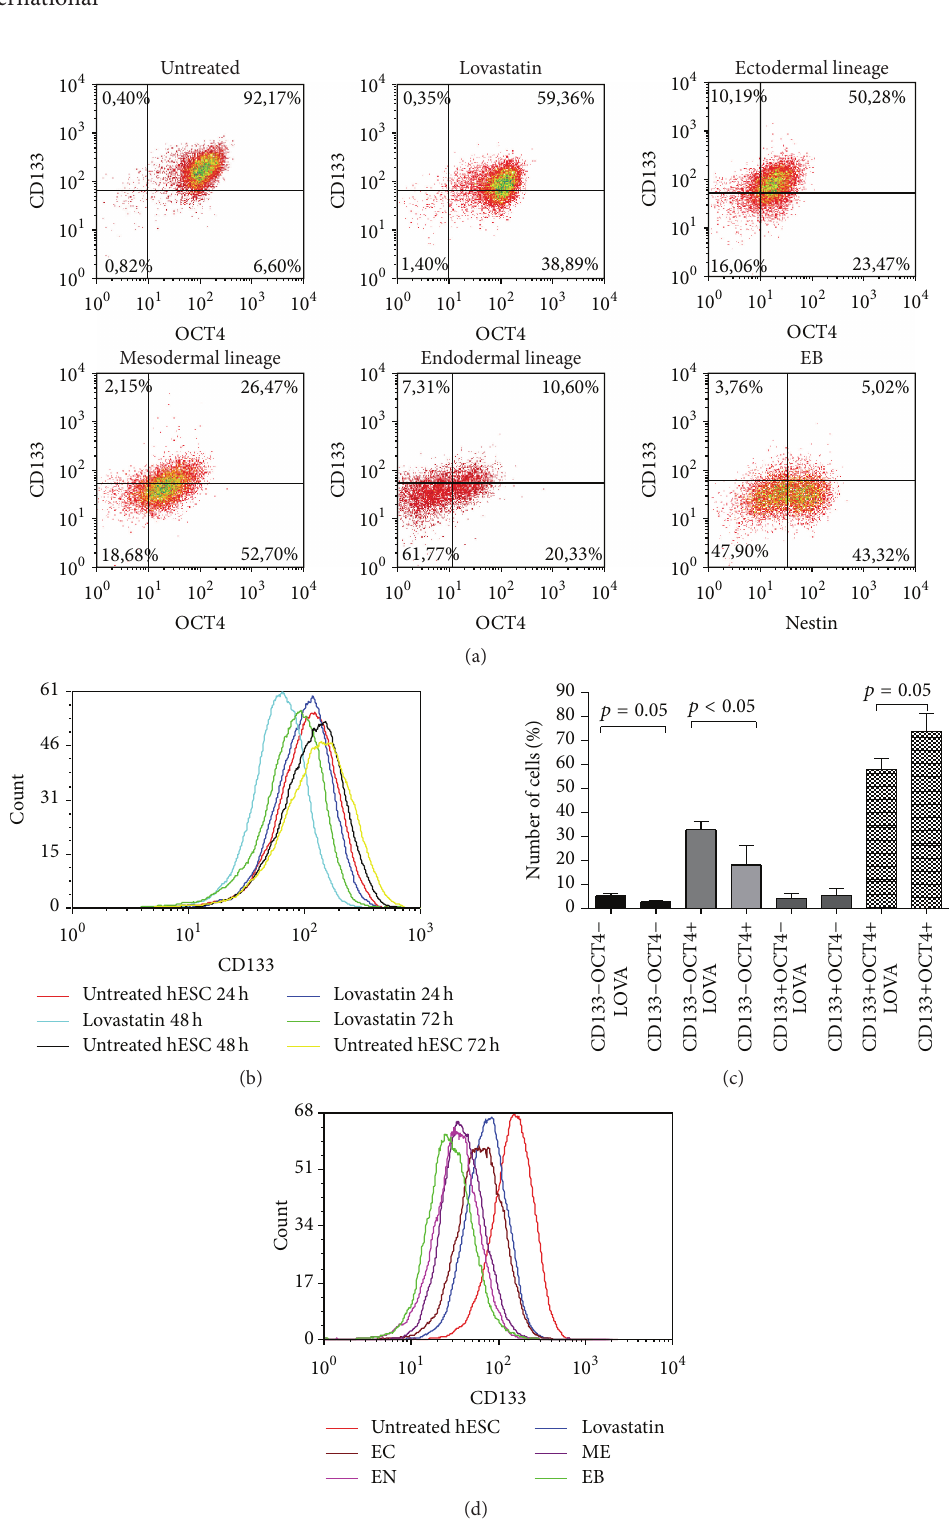
Figure 6: Lovastatin decreased the expression of CD133 in hES cells. Expression of CD133 (AC133 epitope) and the pluripotency marker OCT4 in lovastatin treated hES cells, during differentiation into ectodermal (EC), mesodermal (ME), or endodermal (EN) lineages and after the formation of embryoid bodies (EB). (a) hES cells were stained with anti-CD133 (PE), anti-OCT4 (Alexa Fluor 647), or anti-nestin (Alexa Fluor 647 conjugate) antibodies and with DAPI. For analysis cellular debris and doublets were excluded. (b) CD133 expression levels in untreated and lovastatin (20 𝜇 M) treated hES cells at various time points over 24–72 h. (c) Number of cells in each subpopulation according to the coexpression of CD133 and OCT4. Results are shown as mean ± SD ( 𝑛 = 5 ). (d) Histograms of CD133 expression in pluripotent hES cells and differentiating hES cells (untreated and lovastatin treated